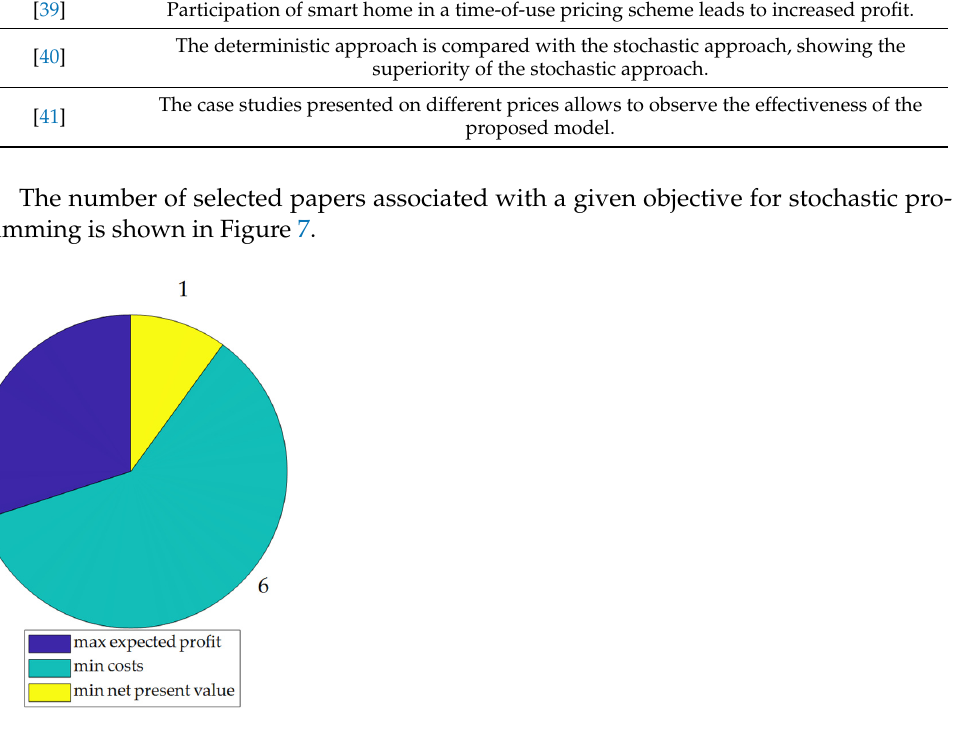
Figure 7. Number of selected papers associated with a given objective for stochastic programming.